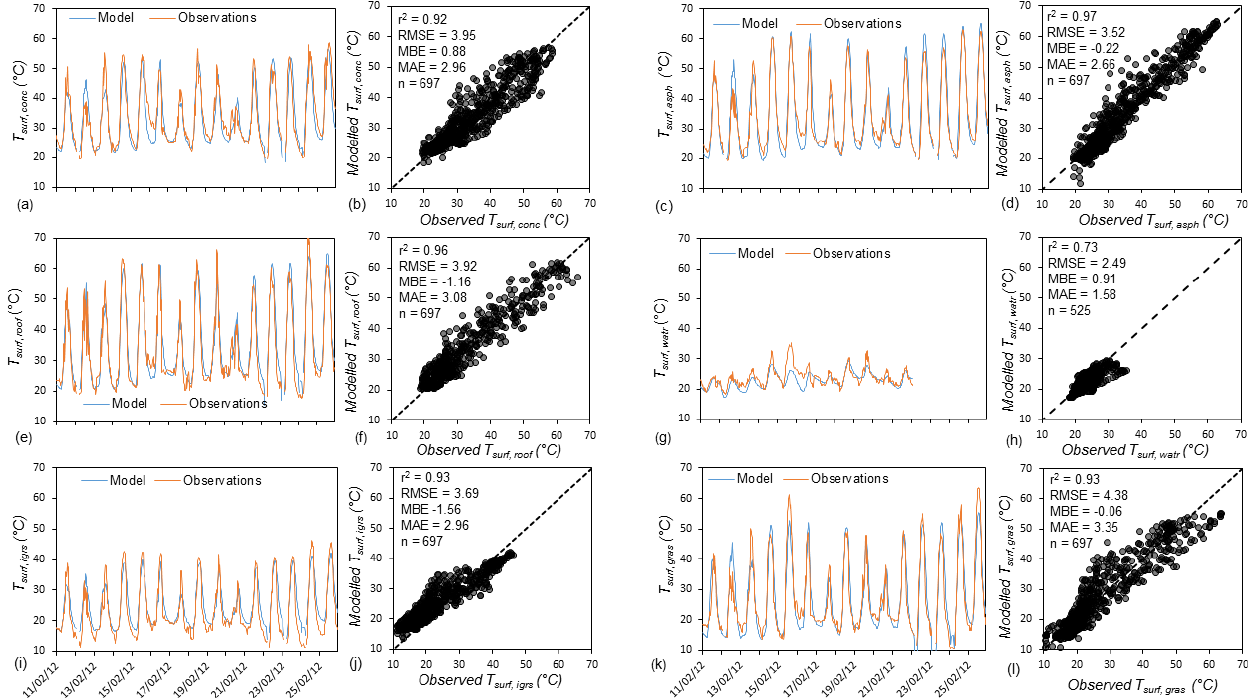
Figure 4. Observed vs. modelled (a, b) T surf , conc , (c, d) T surf , asph , (e, f) T surf , roof , (g, h) T surf , watr , (i, j) T surf , irgs , and (k, l) T surf , gras . All time series plots are for the period 11–25 February. Note that the water site only had observational data for the period 11–21 February due to instrument failure; r 2 is the correlation coefficient, RMSE is the root mean square error, MBE is the mean bias error, and MAE is the mean absolute